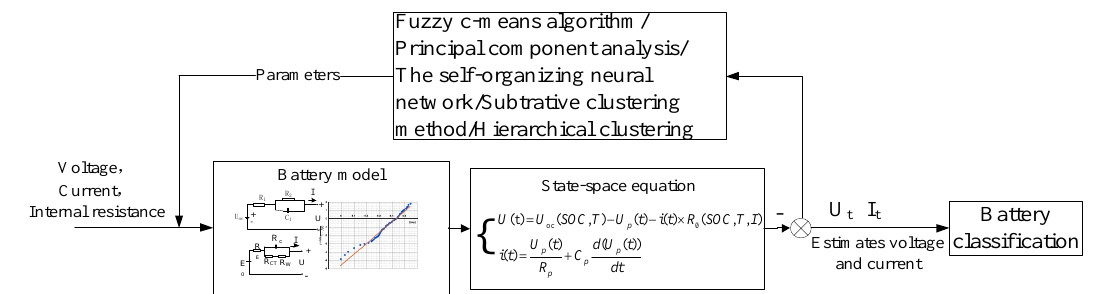
Figure 14. Schematic diagram of the identification model parameter flow with feedback.